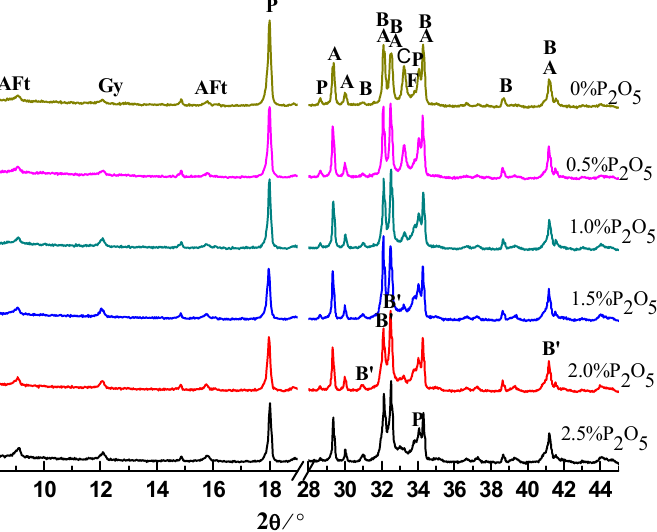
Figure 3. XRD patterns of cement pastes hydrated for 0.5 day. A: C 3 S; B: β -C 2 S; F: C 4 AF; C: C 3 A; P: CH; B ′ : α′ -C 2 S-xC 3 P.